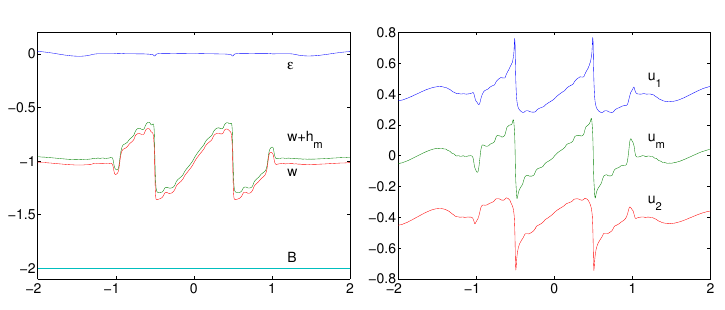
of the intermediate layer is increased to (cid:98) h m = 0 . 1, the oscillations are further